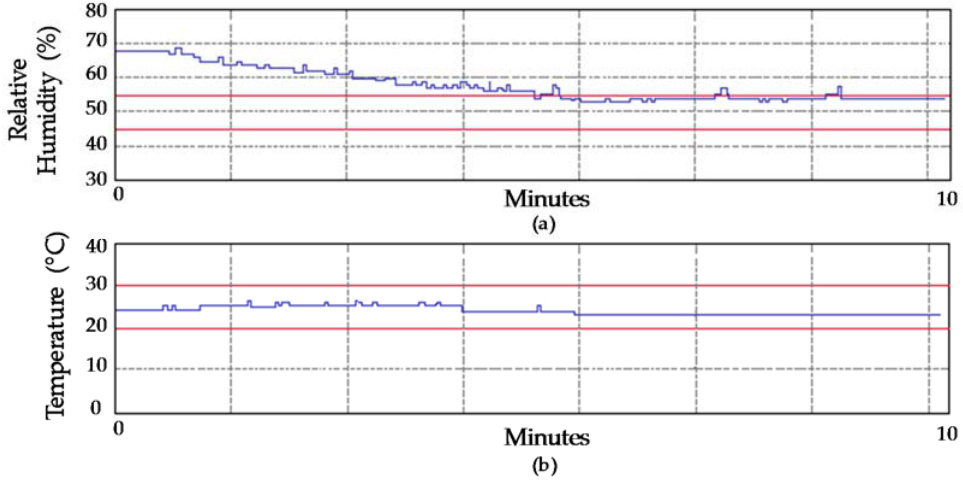
Figure 11. Results obtained when the relative humidity is above the set point and the temperature is in the defined range. ( a ) Relative humidity; ( b ) Temperature.